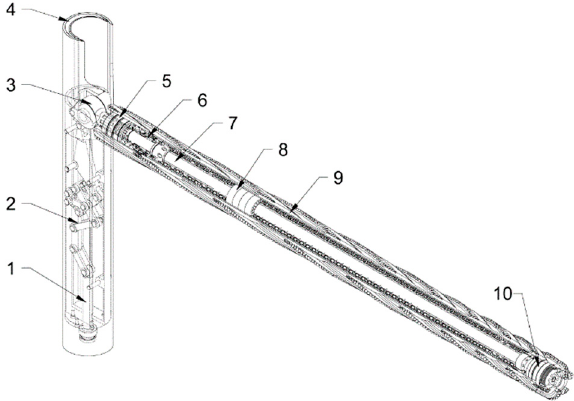
Figure 6. Structural diagram of the special tool with the rotating bit: 1—rod of the linear actuator, 2—lever mechanism, 3—hinge, 4—cavity between the housing and the casing for supplying the flushing fluid, 5—rolling support, 6—reducer, 7—shaft, 8—turbine sections, 9—body—drill bit; 10—rolling support.